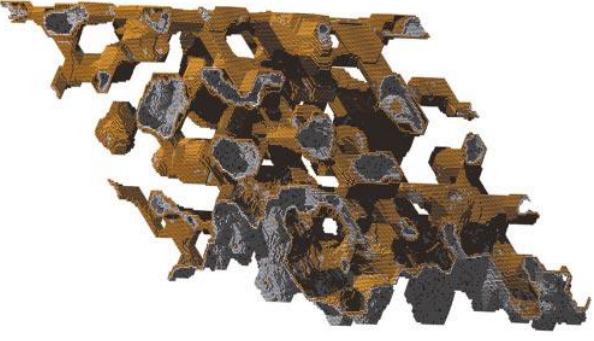
Figure 1. Simulated nanoporous gold. The simulation model was as follows: a bond-breaking model was used for diffusion; atoms with N nearest neighbors diffused with rate 13 s −1 . Dissolution rates , where e is a bond energy and v D = 10 were consistent with the Butler-Volmer (BV) equation in the high-driving-force Tafel regime; the dissolution rate k for a silver atom with N nearest neighbors was written E,N as , where v = 10 4 s −1 is an attempt frequency determined E by the exchange-current density in the BV equation and ϕ is the over-potential. For the Figure, ϕ = 1.75 eV, ϵ/k T = 5.51. Reprinted with permission from [39]. Copyright B